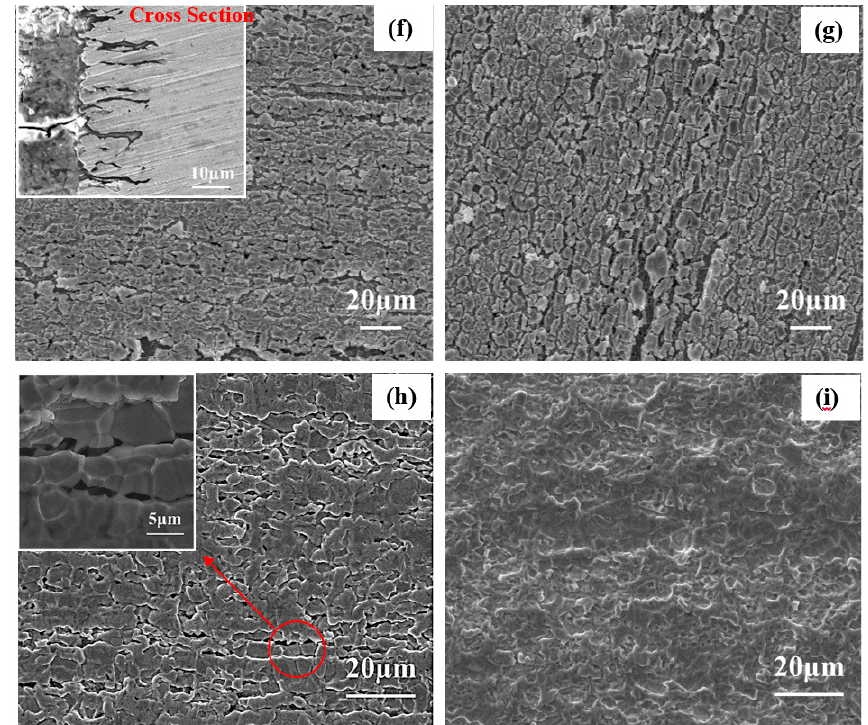
Figure 6. Corrosion micro-morphology SEM images of 2205 DSS after 8 h of immersion in ( a ) 0.1 mol/L HCl, ( b ) 0.137 mol/L HCl, ( c ) 0.1 mol/L HCl + 0.385 mmol/L Na 2 S, ( d ) 0.1 mol/L HCl + 3.846 mmol/L Na 2 S, ( e ) 0.137 mol/L HCl + 0.128 mmol/L Na 2 S, ( f ) 0.137 mol/L HCl + 0.385 mmol/L Na 2 S, ( g ) 0.548 mol/L HCl, and ( h ) without corrosion product film 0.137 mol/L HCl + 0.385 mmol/L Na 2 S, ( i ) without corrosion product film 0.548 mol/L HCl.